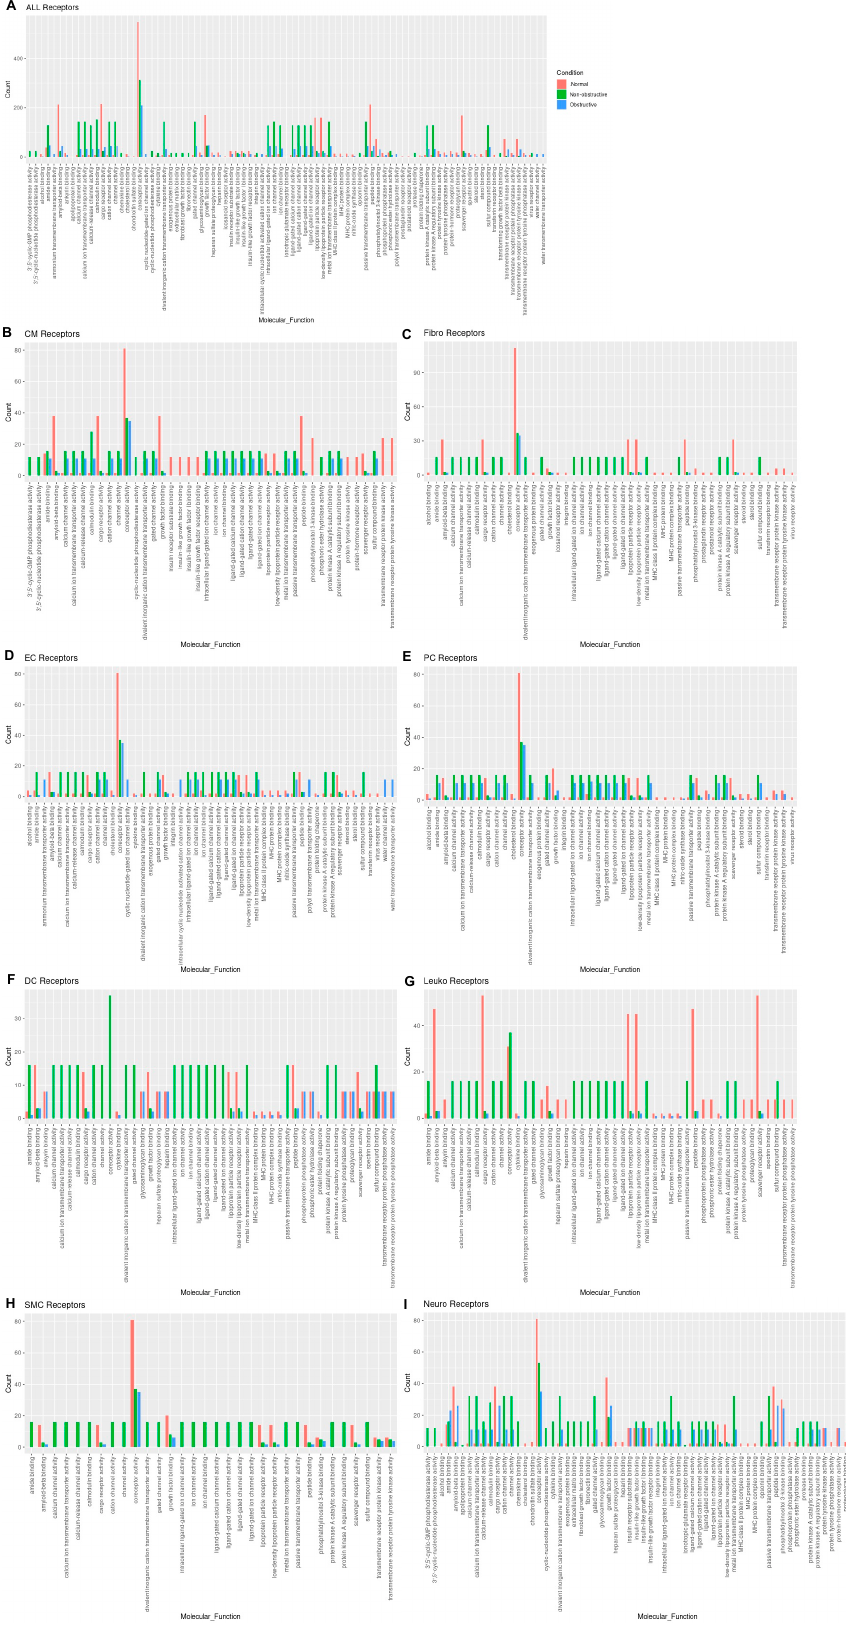
Figure 6. Bar plot representing the total count of receptors (in expressed ligand–receptor pairs) associated with different cellular processes in normal, nonobstructive HCM, and obstructive